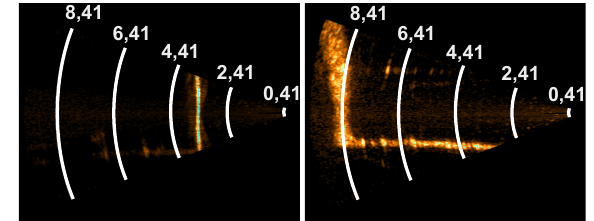
Figure 4: Multi-beam echo-sounder swaths under two different incidence angles. Left: almost perpendicular incidence (see red line in Fig. 5); Right: small grazing angle (see green line in Fig. 5)). The swath is wider in the second case. Distances are given in meters